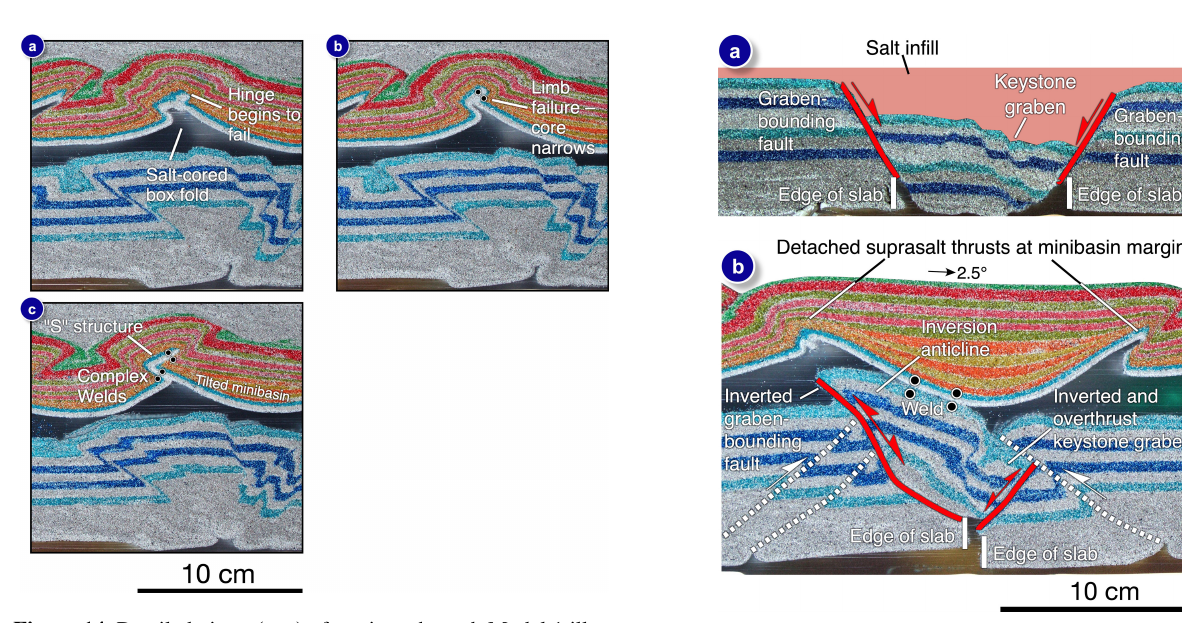
Model 2. Note the asymmetric geometry and the formation of a key- stone structure. (b) Detailed view of an inverted subsalt graben from Model 1. Inversion of this graben uplifted and welded the overlying extensional